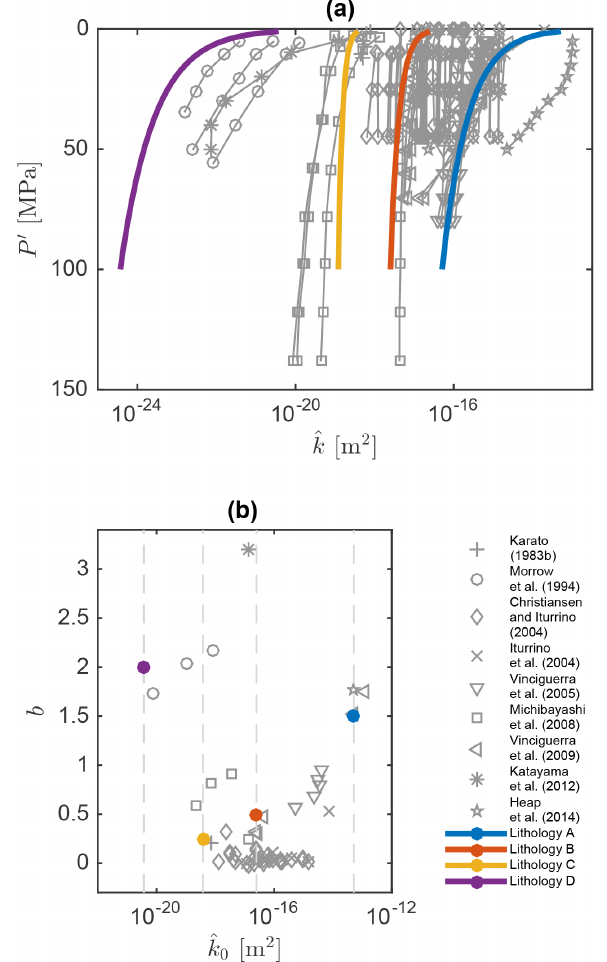
Figure 8. (a) Hydraulic permeability versus effective confining pressure and (b) values for the coefficient b versus the ambient confining-pressure permeability. Gray graphs are the permeability data reported in the literature and colored curves and dots indicate values used to parameterize lithology